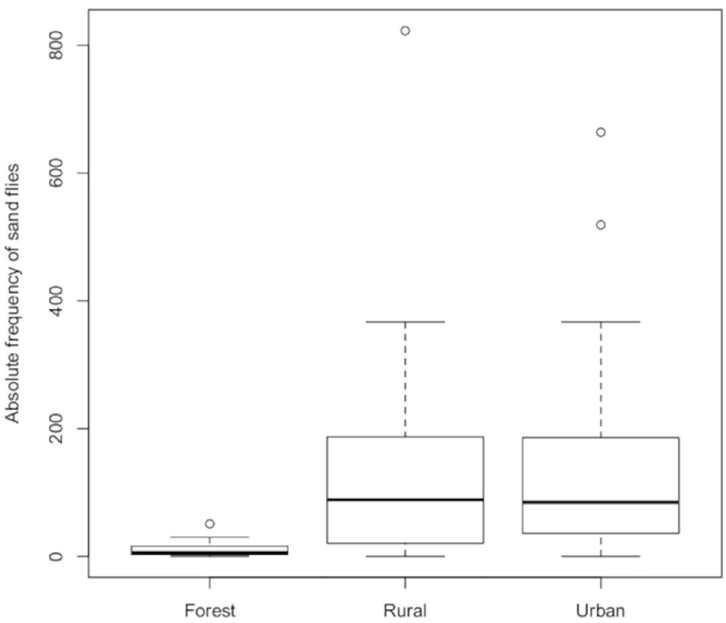
Fig 2. Absolute frequency of sandflies in three areas (forested, rural, urban). Corumba´, Mato Grosso do Sul, Brazil. May 2015 to April 2017. https://doi.org/10.1371/journal.pone.0215741.g002 PLOS ONE | https://doi.org/10.1371/journal.pone.0215741 May 14,